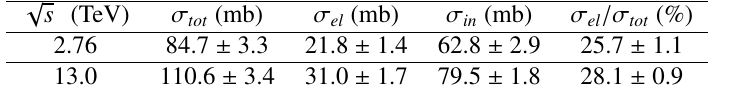
Table 1. Summary of cross-section results of TOTEM at √ s = 2 . 76 and 13 TeV in pp collisions [1, 3, 4, 51].